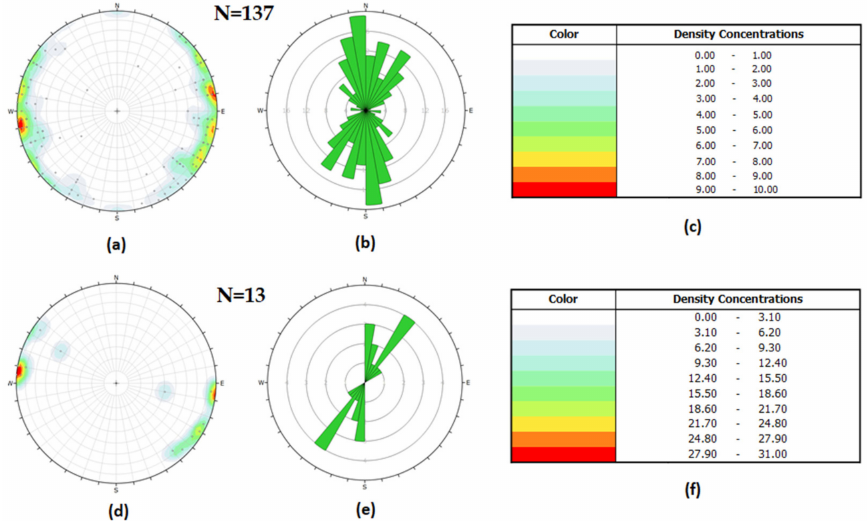
Figure 8. ( a ) Stereoplot (lower hemisphere; multiple uniform distribution contouring), ( b ) rose diagram of the main fracture planes, and ( c ) the related legend, and ( d ) stereoplot (lower hemisphere; multiple uniform distribution contouring), ( e ) rose diagram of the tectonic stylolite planes, and ( f ) the related legend, measured from the cores extracted from the Eureka 1 DEV well.